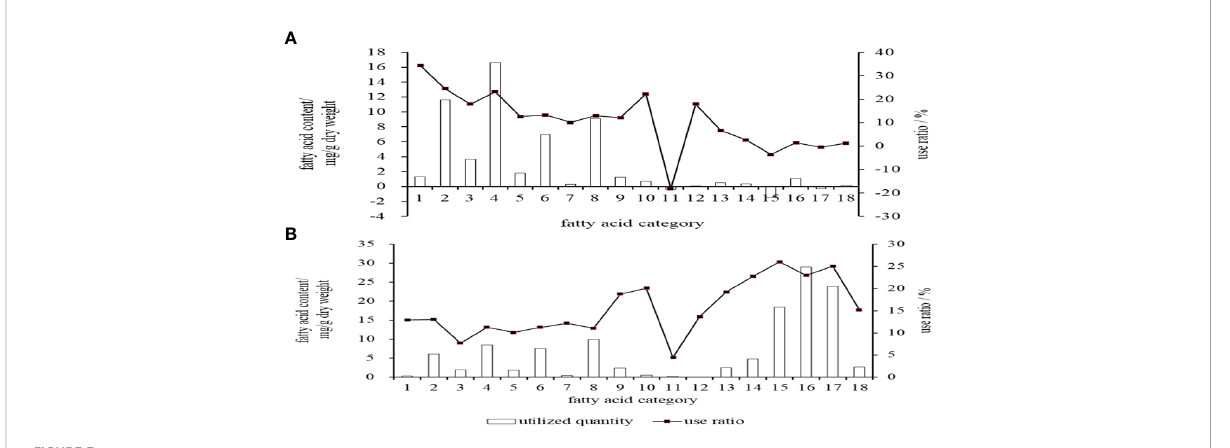
FIGURE 3 Utilization degree of the main fatty acids of cobia. ( A : in embryos stage; B : in endogenous vegetative larvae stage). 1.C14:0, 2.C16:0, 3.C18:0, 4. ∑ SFA 5.C16:1, 6.C18:1n9c, 7.C20:1n9, 8. ∑ MUPA, 9.C18:2n6, 10.C18:3n3, 11.C20:4n6, 12.C20:3n3, 13.C20:5n-6(EPA), 14.C22:5n3 (DPA), 15.C22:6n3(DHA), 16. ∑ PUFA,17. ∑ n-3PUFA, 18. ∑